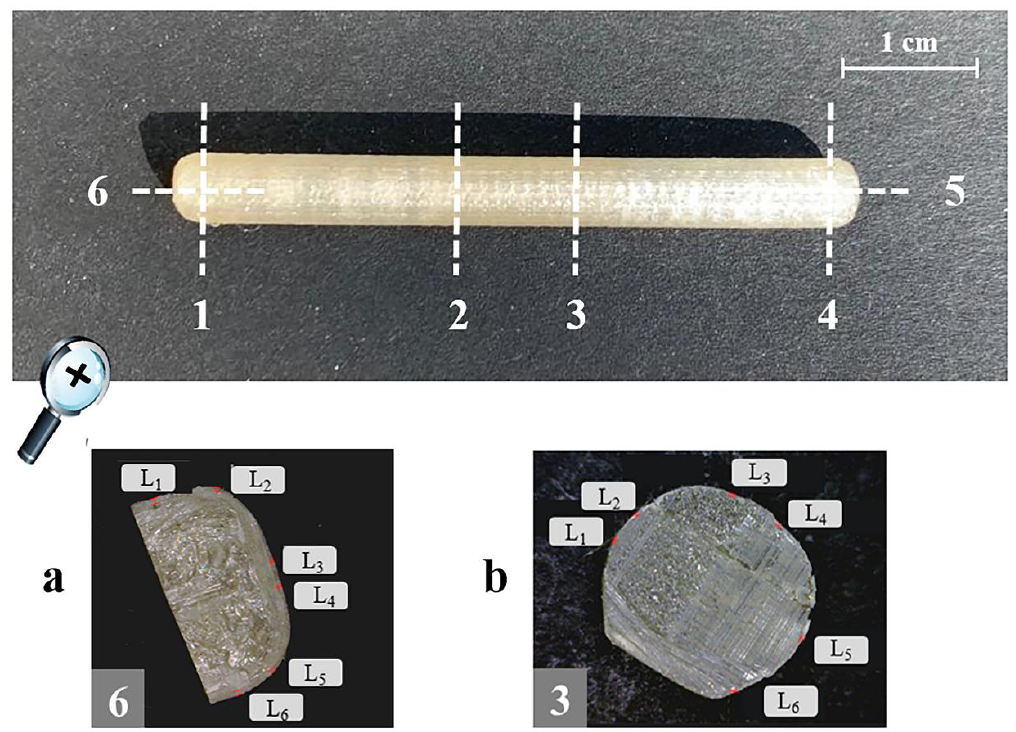
Figure 2. Outline of the positions in which each I-shaped sample was cut, together with photographs of the resulting cross-sections (types a and b). By way of example, details relevant to the thickness measurements (L 1 – L 6 ) of the coating layer taken at position 3 and 6 are highlighted.